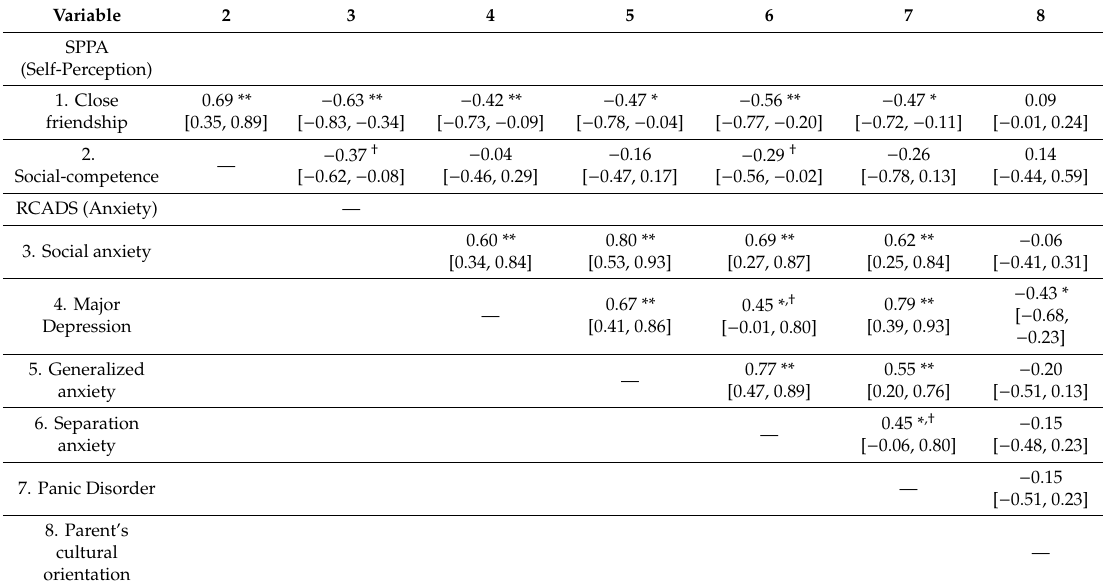
Table 2. Correlation matrix for study variables for BAME immigrant adolescents ( n = 26). 95% percentile bootstrap confidence intervals in parentheses.